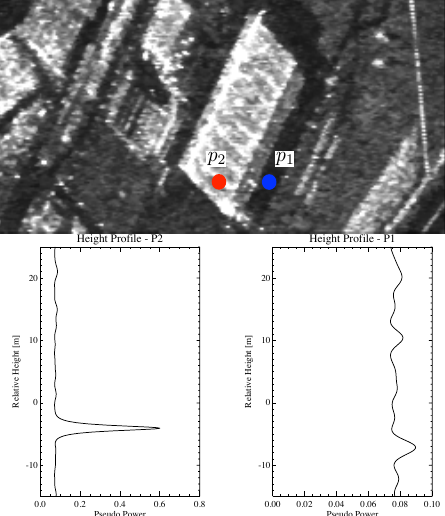
Figure 6: Top : Filtered SAR amplitude corresponding to the main building (1). p 1 and p 2 are located in blue and red re- spectively. Bottom : Pseudo-spectrum profile corresponding to p 2 and p 1 illustrating the difference between a peak and back- ground